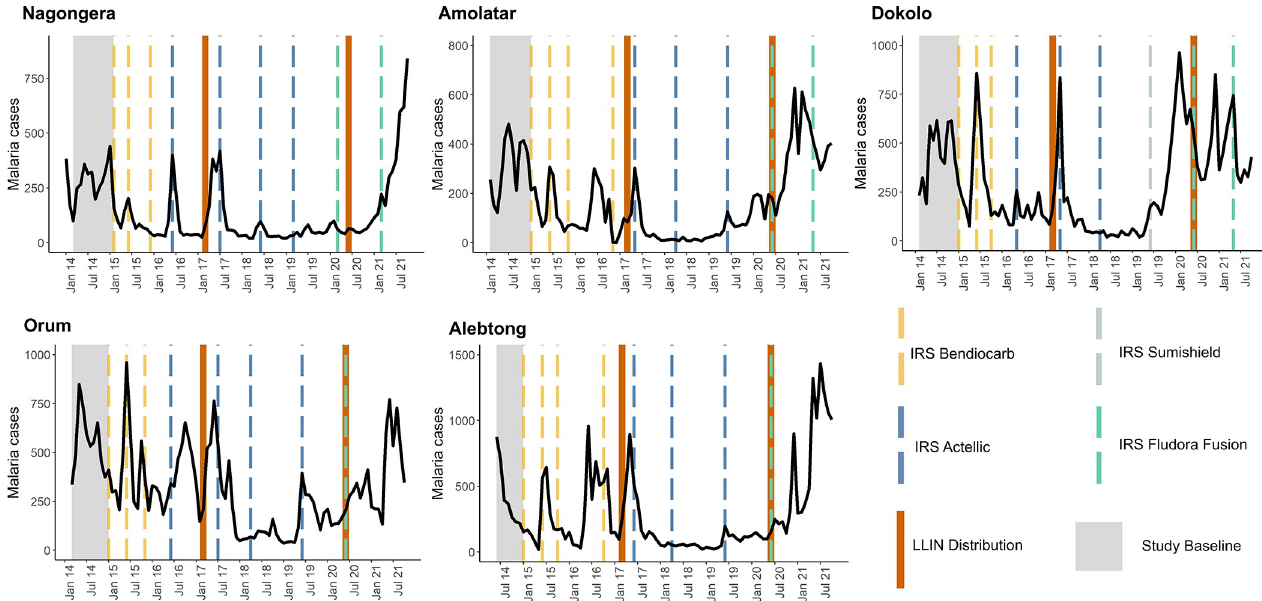
Fig 2. Malaria case counts and vector control interventions over time at 5 IRS sites. The study baseline period (pre-IRS) is indicated in